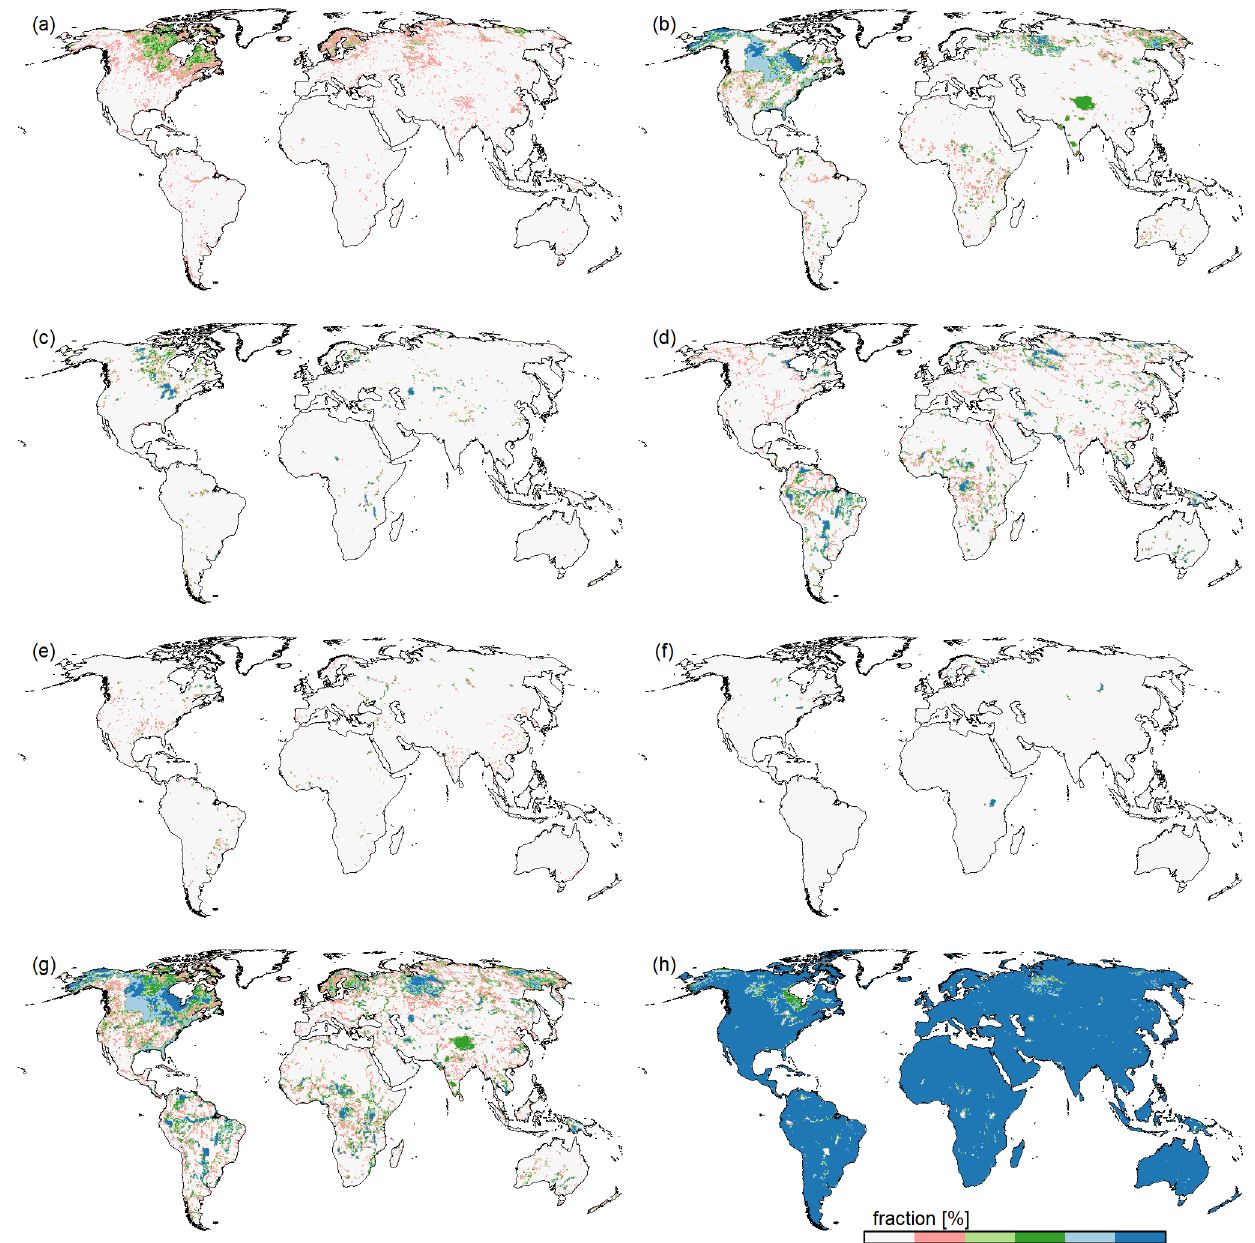
Figure D1. Fraction of local lakes (a) , local wetlands (b) , global lakes (c) , global wetlands (d) , global reservoirs (e) , regulated lakes (f) , grid cell area covered by LResWs (represents the maximum extent of LResWs) and land fraction (represents minimum extent of